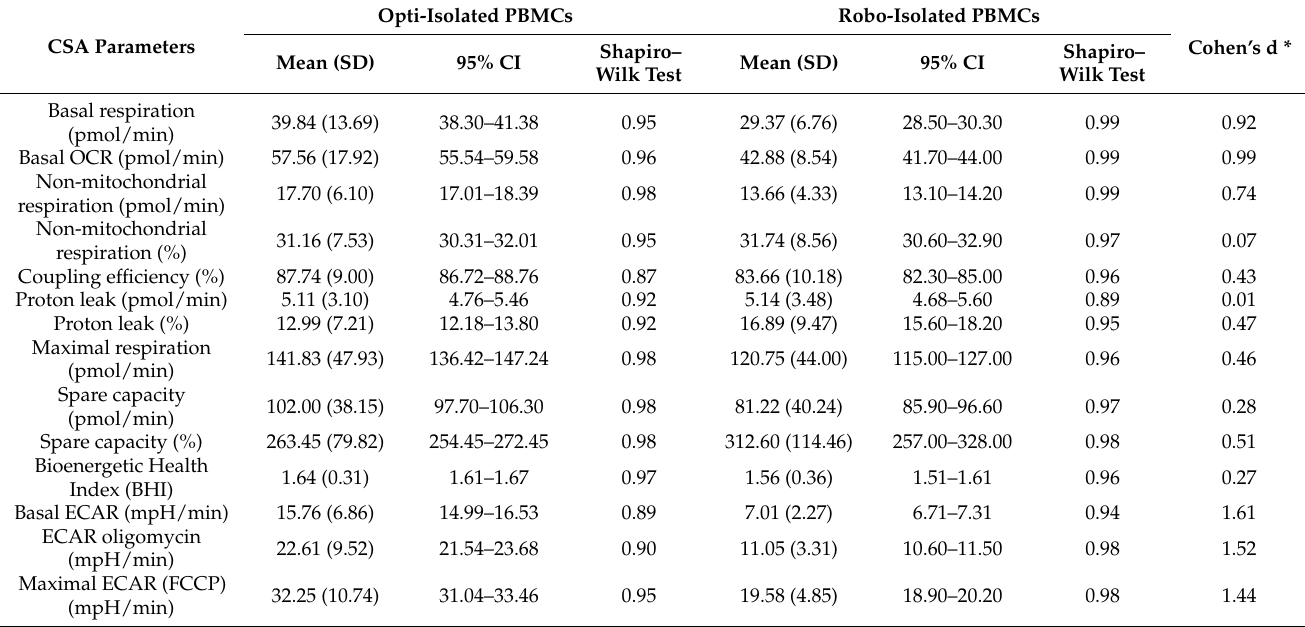
Table 1. Variations in the results of cellular stress assay (CSA) parameters in Opti-isolated PBMCs ( n = 302) and Robo-isolated PBMCs ( n = 216).